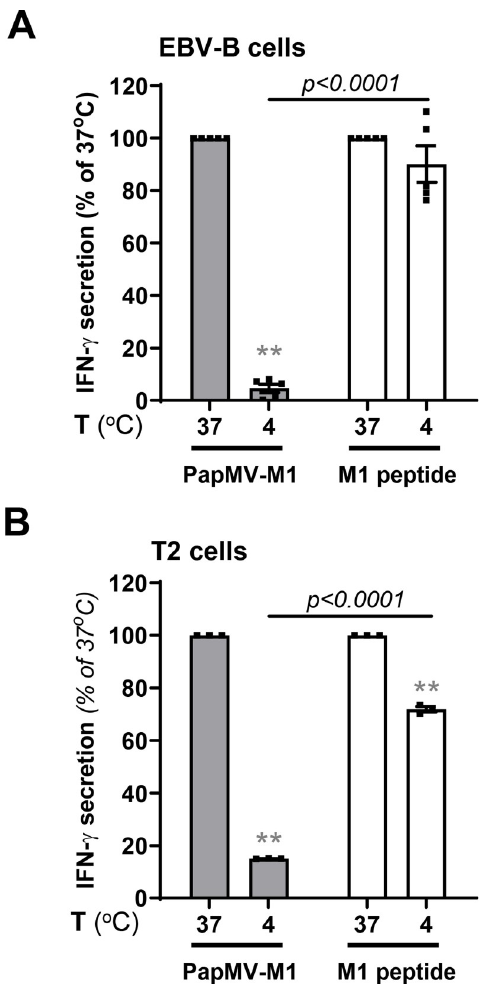
Fig 1. TAP-independent MHC class I cross-presentation of PapMV VLPs requires active processing. EBV-B (A) or T2 (B) cells were loaded with PapMV-M1 or M1 peptide for 6 hours at 4˚C or 37˚C. Cells were then washed and co- cultured with M1-specific CD8 + T lymphocytes for 16–18 hours at a 1:1 ratio. Supernatants were collected and IFN- γ was quantified by ELISA to evaluate MHC-I antigen cross-presentation. Results are represented as mean ± SEM (standard error of the mean), % of IFN- γ secretion at 37˚C. Data were pooled from five (A) or three (B) independent experiments. Statistical significance (defined at p < 0.05) was calculated using one sample t test ( � p < 0.05, �� p < 0.01). When comparing PapMV VLP cross-presentation with the cross-presentation of the control peptide at corresponding temperature, statistical significance (defined at p < 0.05) was calculated using a two-tailed unpaired Student’s t-test; p values are